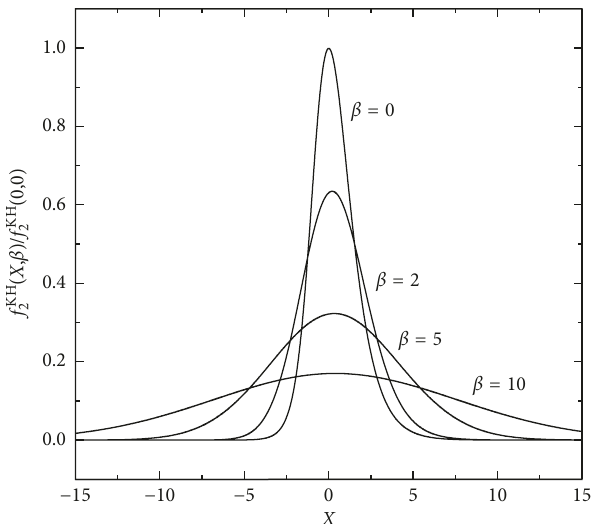
Figure 4: The influence of the distribution parameter β on the width and height of the KH peak (Equation 23).